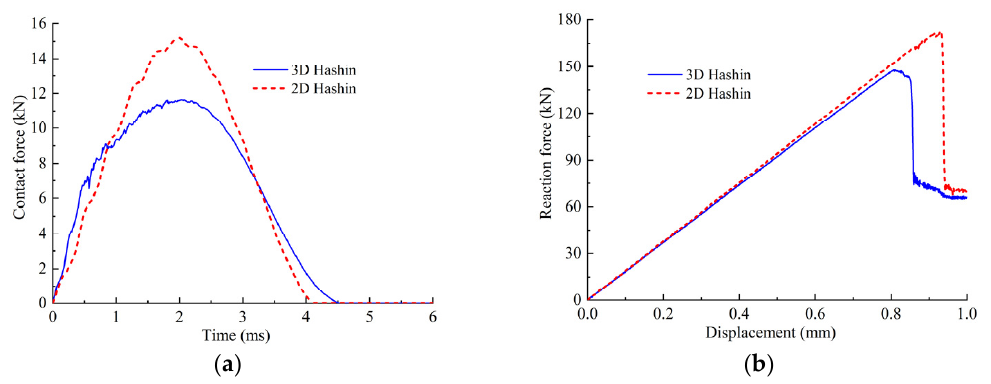
Figure 12. Results with two damage criteria. ( a ) The contact force. ( b ) The reaction force.